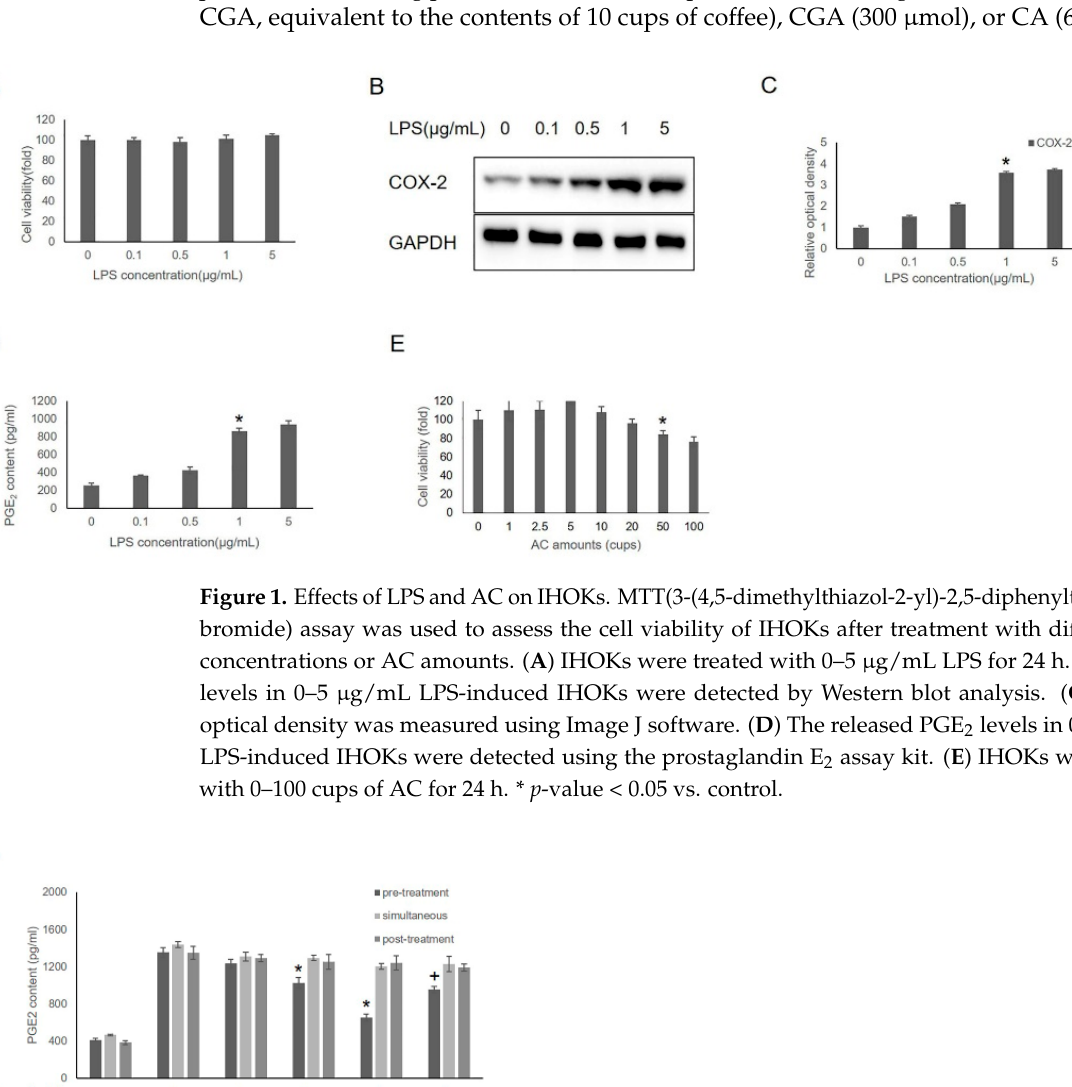
Figure 1. Effects of LPS and AC on IHOKs. MTT(3-(4,5-dimethylthiazol-2-yl)-2,5-diphenyltetrazo- lium bromide) assay was used to assess the cell viability of IHOKs after treatment with different LPS concentrations or AC amounts. ( A ) IHOKs were treated with 0–5 µg/mL LPS for 24 h. ( B ) COX- 2 levels in 0–5 µg/mL LPS-induced IHOKs were detected by Western blot analysis. ( C ) Relative optical density was measured using Image J software. ( D ) The released PGE 2 levels in 0–5 µg/mL LPS-induced IHOKs were detected using the prostaglandin E 2 assay kit. ( E ) IHOKs were treated with 0–100 cups of AC for 24 h. * p- value < 0.05 vs. control.